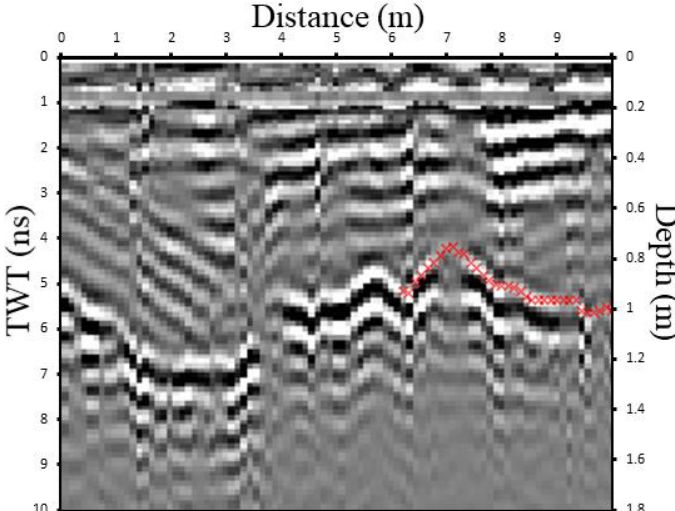
Figure 3. Schematic diagram of the methods for processing terrestrial laser scanning (TLS), GPR, and field measurements, and calculating LWC.